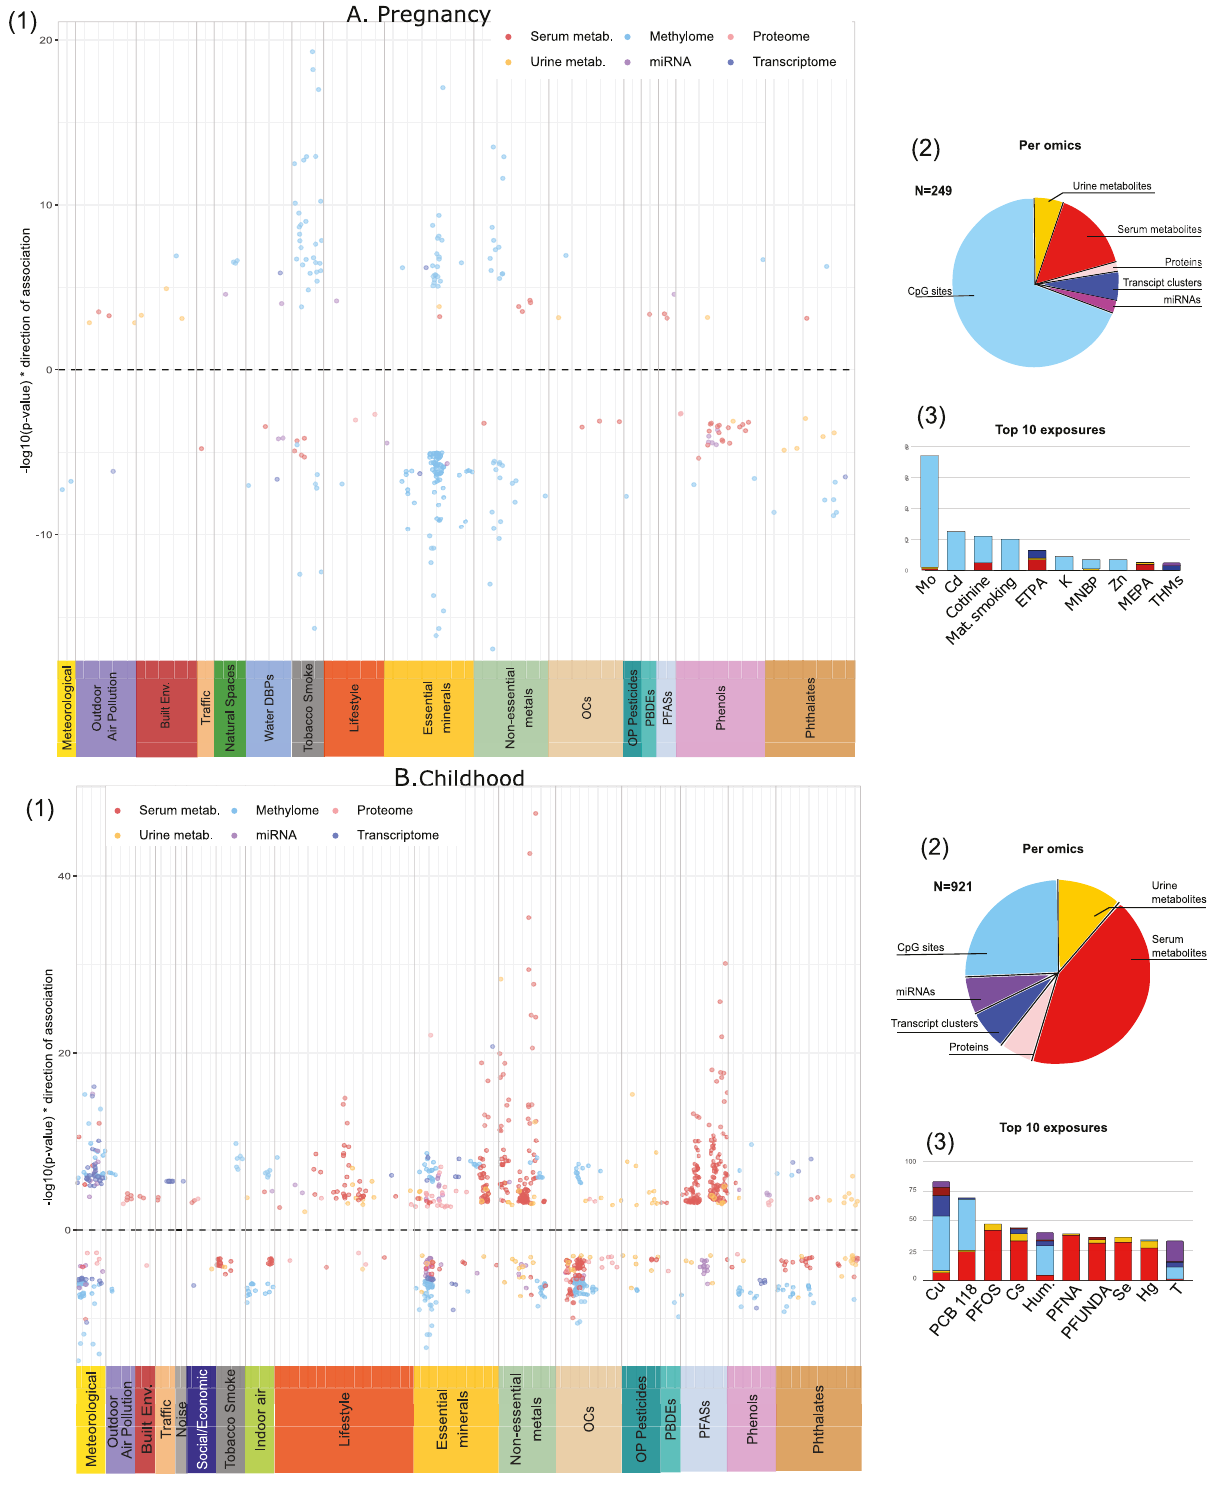
Fig.2|ResultsoftheExposome-omics-WideAssociationStudy(ExWAS)forthe pregnancy and childhood exposomes. A Summary of the associations between the pregnancy exposome and multi-omics measured in 1301 children: Miami plot (1); pie charts showing the proportion of associations with the different molecular layers (2); and top 10 pregnancy exposures (3). B Summary of the childhood exposome-child omics associations: Miami plot (1); pie charts showing the pro- portionofassociationswiththedifferentmolecularlayers(2);andtop10childhood